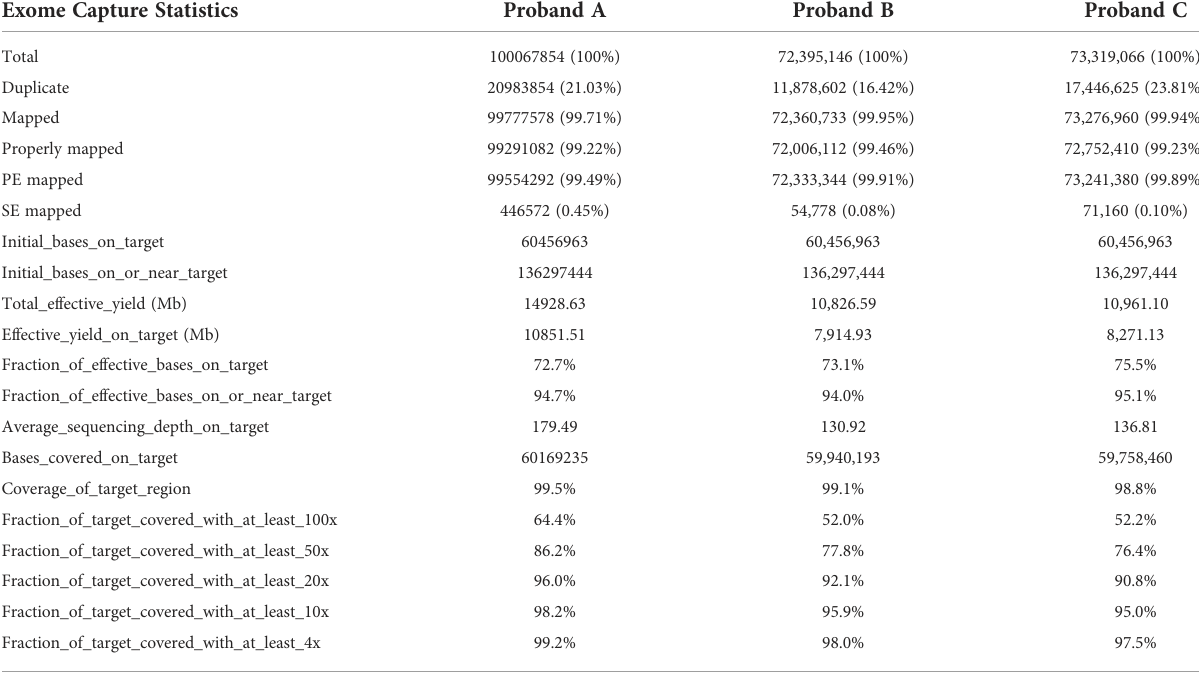
TABLE 2 Whole exome sequencing